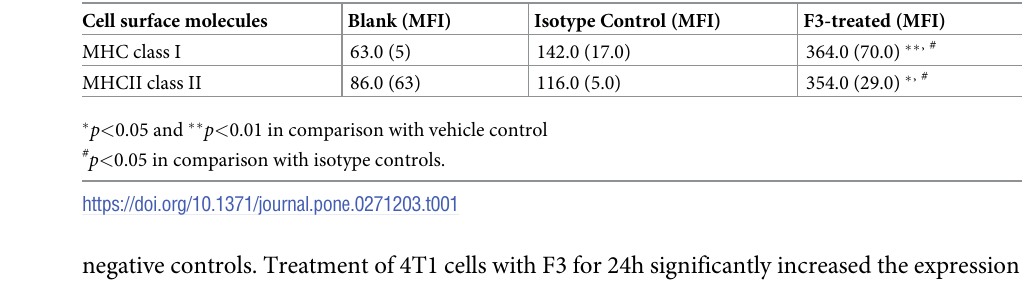
negative controls. Treatment of 4T1 cells with F3 for 24h significantly increased the expression of MHC class I ( p = 0.008) and MHC class II ( p = 0.034) surface proteins, when compared